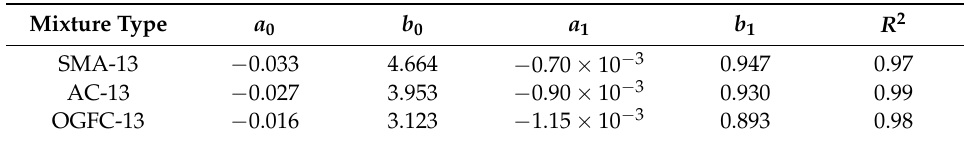
Table 5. Parameters of the triaxial strength model considering the influence of temperature and confining pressure.